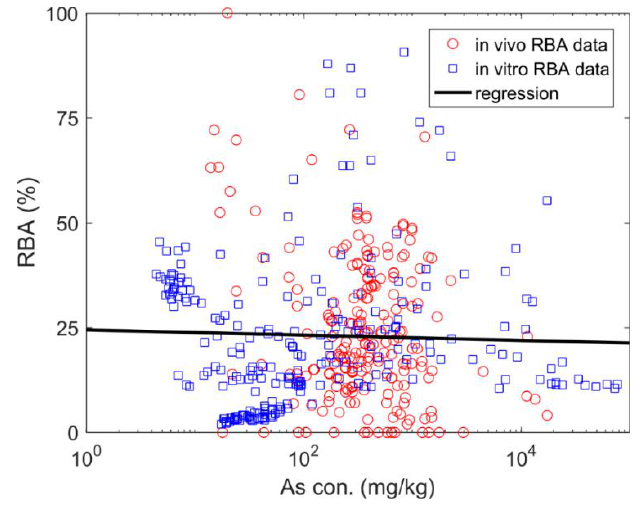
Figure 1. The relation between arsenic (As) concentration (con.) and its relative bioavailability (RBA).